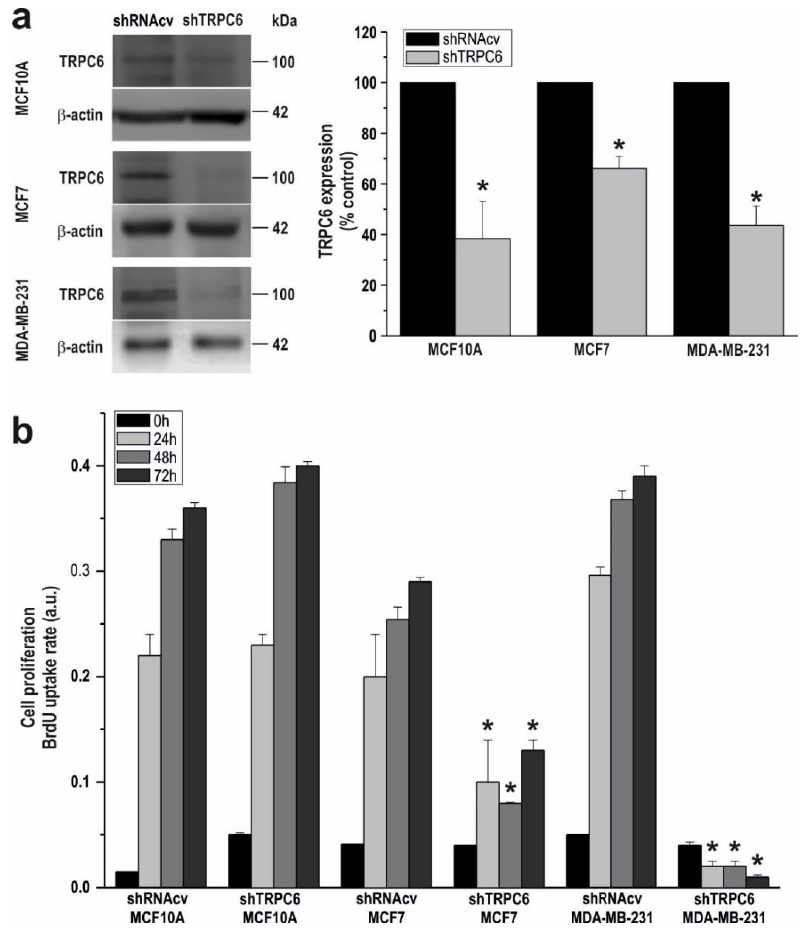
Figure 2. TRPC6 expression is required for MCF7 and MDA-MB-231 cell proliferation. ( a ) MCF10A, MCF7 and MDA-MB-231 cells were transfected with shTRPC6 or shRNA control vector (shRNAcv), as indicated. After 48h cells were lysed and subjected to Western blotting with anti-TRPC6 antibody, followed by reprobing with anti- β -actin antibody for protein loading control. Molecular masses indicated on the right were determined using molecular-mass markers run in the same gel. ( b ) MCF10A, MCF7 and MDA-MB-231 cells were transfected with shTRPC6 or scramble plasmid and 48 h later cell proliferation was assessed for a further 24, 48 and 72 h using the BrdU cell proliferation assay kit, as described in the Material and Methods. Bar graphs represent cell proliferation 0, 24, 48 and 72 h after cell transfection, presented as BrdU uptake rate. * p < 0.05 compared to the corresponding control (cells transfected with shRNAcv).